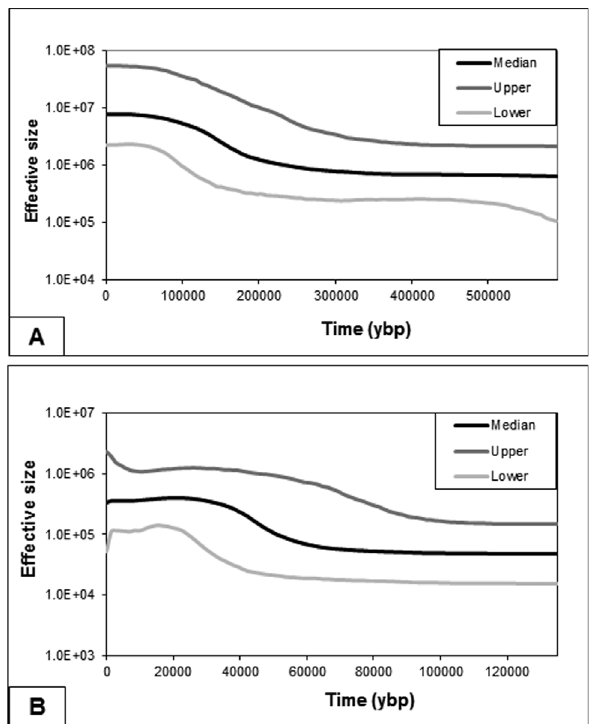
Figure 5 - Bayesian skyline plot showing the effective population size fluctuation of L. colocola through time. (A) Analysis performed with all haplotypes from western South America and (B) Analysis performed with all haplotypes from eastern South